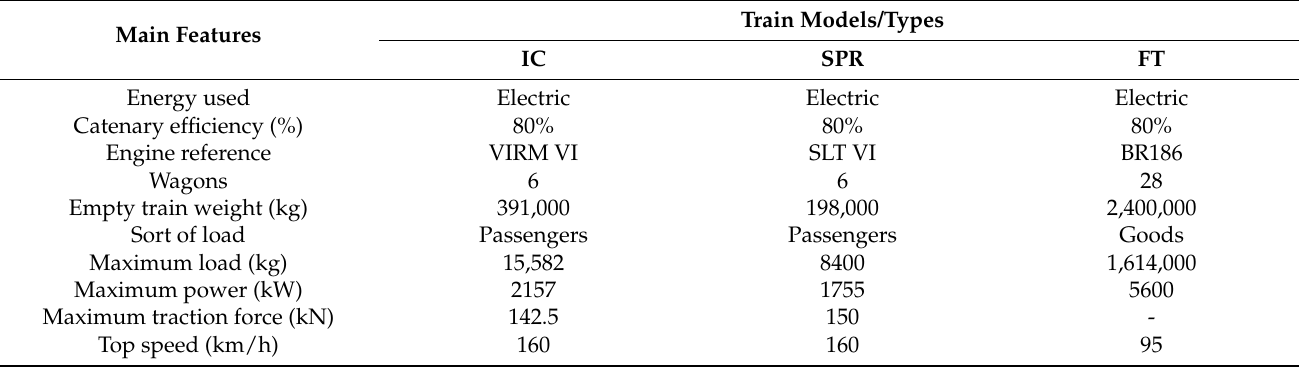
Table 10. Rail transport used for intermediate- and short-distance travels for goods and passenger transportation [55].